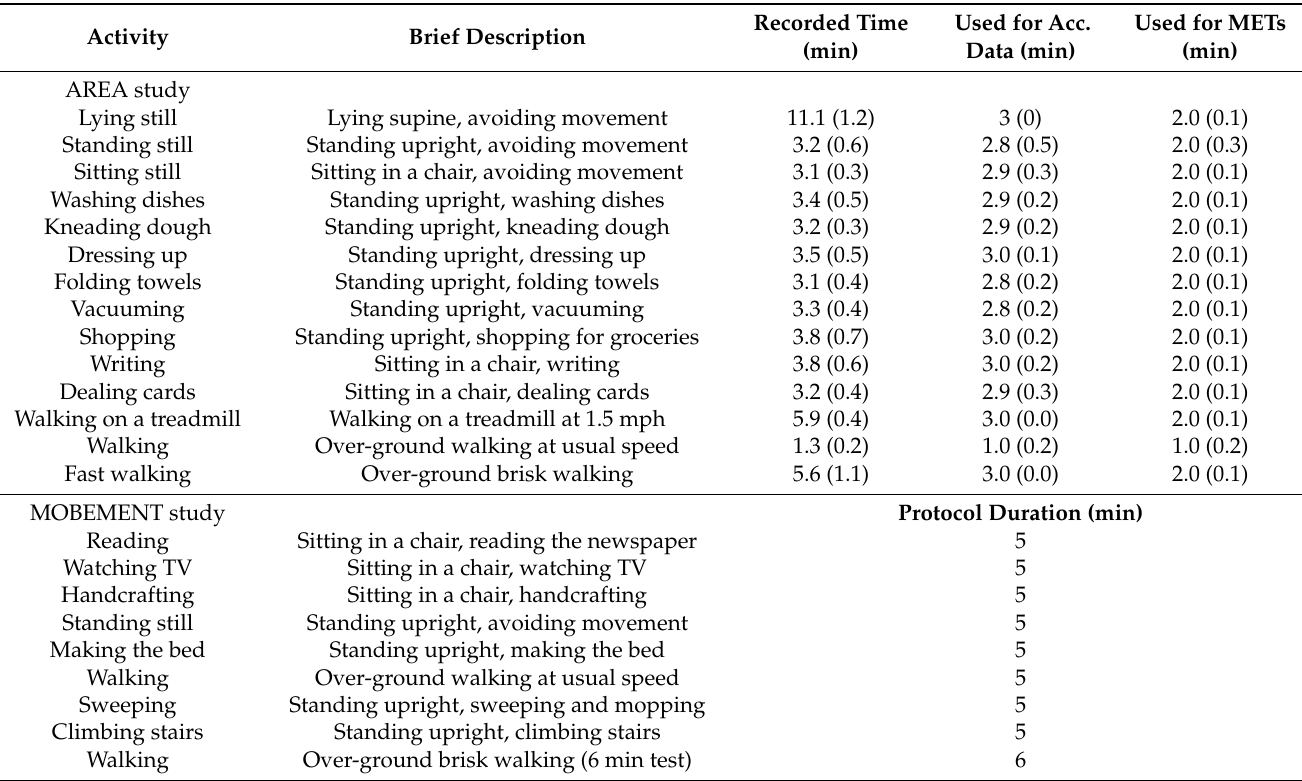
Table 1. Description of the activities performed in the laboratory